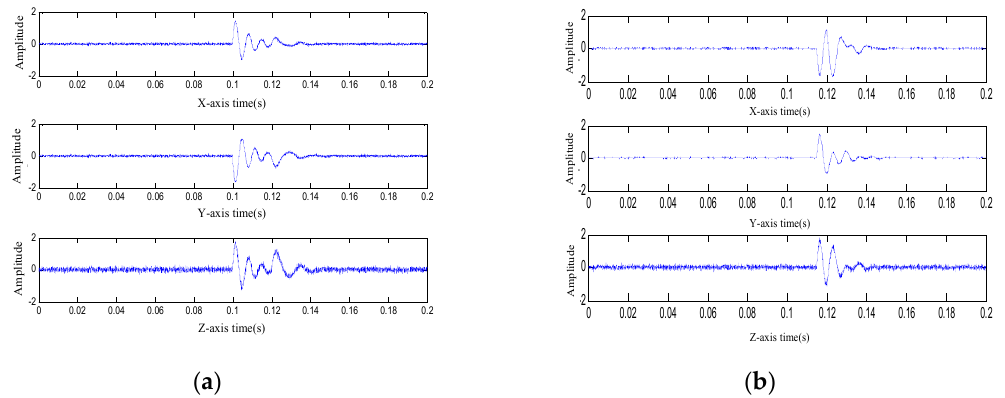
Figure 19. Simulated blasting vibration signals: ( a ) diagram of three component signals of the blasting vibration for node 1 and ( b ) diagram of three component signals of the blasting vibration for node 2. The arrival time of the first break of the two nodes was extracted using the STA/LTA algorithm, as shown in Figure 20.